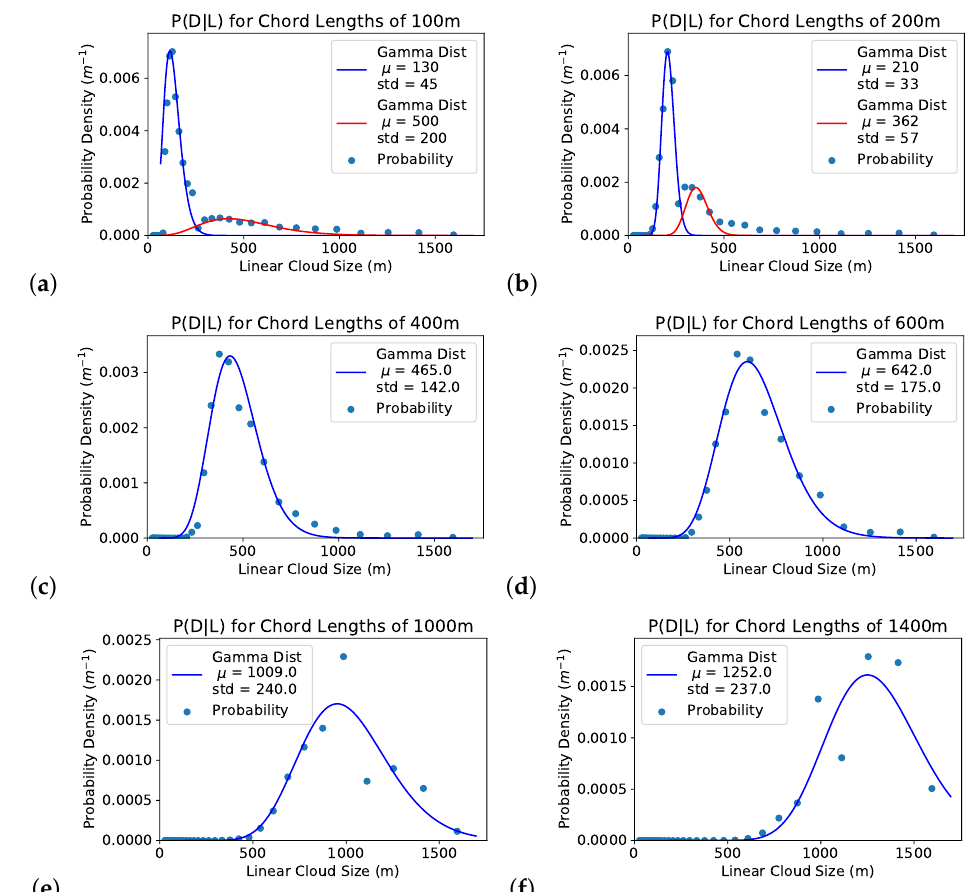
Figure 6. Cloud size distribution conditional on the chord length for the 8th hour of the RICO simulation.